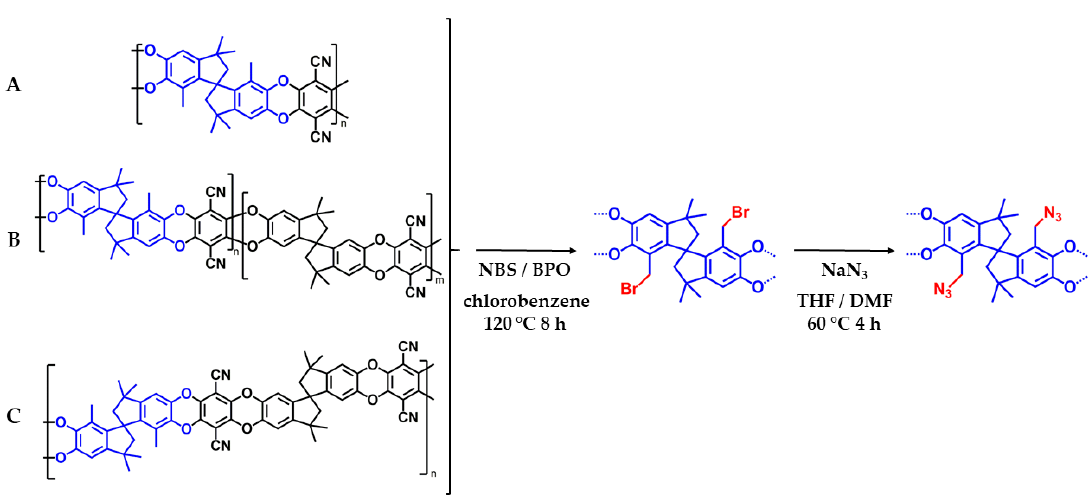
Figure 1. Modification route for the preparation of azide modified polymers of intrinsic microporosity (A: homopolymer—AZ-PIM-100, B: randomly distributed DMTTSBI unit—AZ-PIM-R50 and C: alternating DMTTSBI